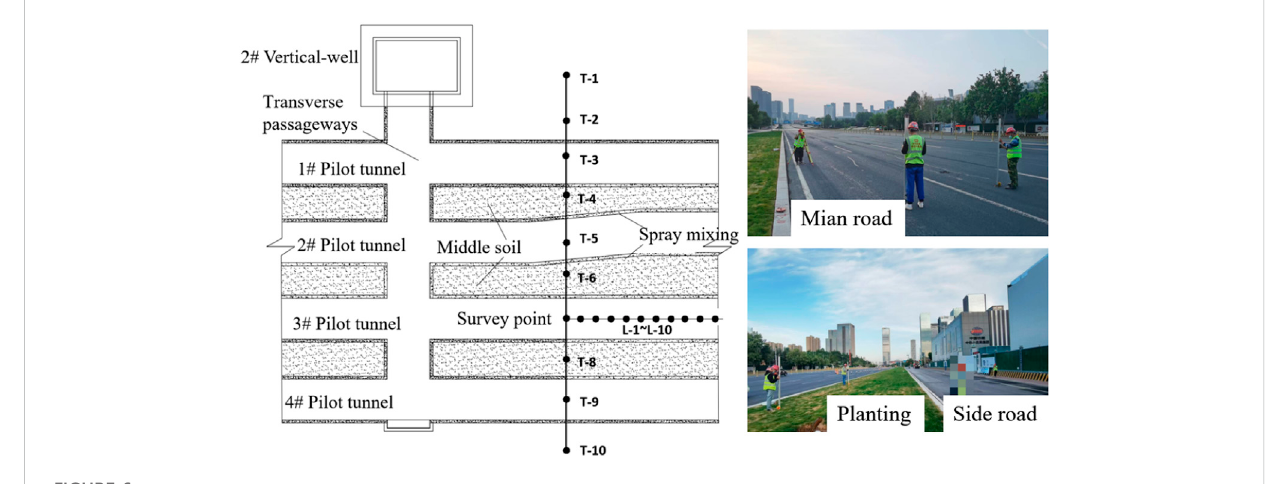
FIGURE 6 Measuring point